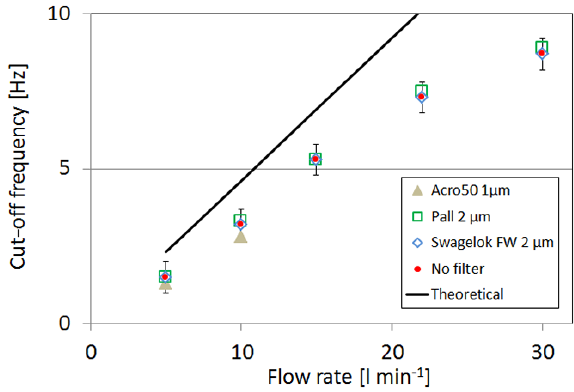
Figure 4. Cut-off frequencies (Hz) as a function of the flow rate (Lmin − 1 ) for LI-7200 with ACRO 50 (grey triangle), PALL 2µm (green squares), Swagelok FW 2µm (blue diamonds), and without any filter (red dots). The full line corresponds to the theoretical pre- diction given by Eq.